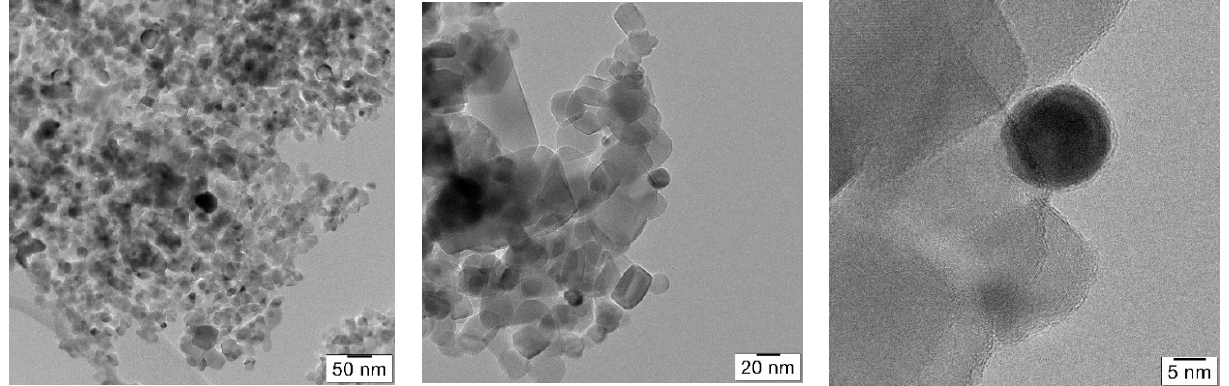
Figure 4. TEM pictures at different magnifications.